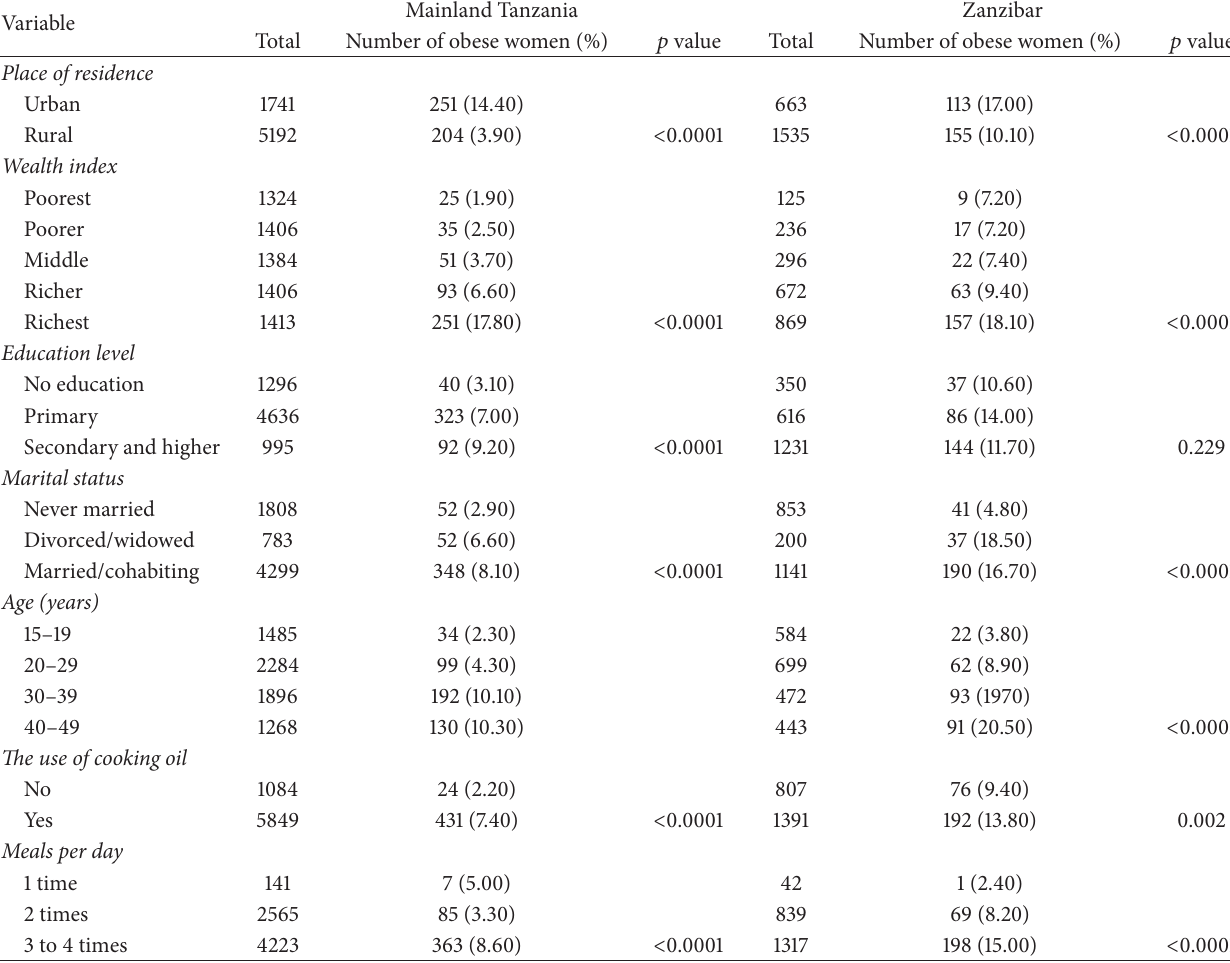
Table 2: Distribution of obesity prevalence among nonpregnant women by baseline characteristics and state.